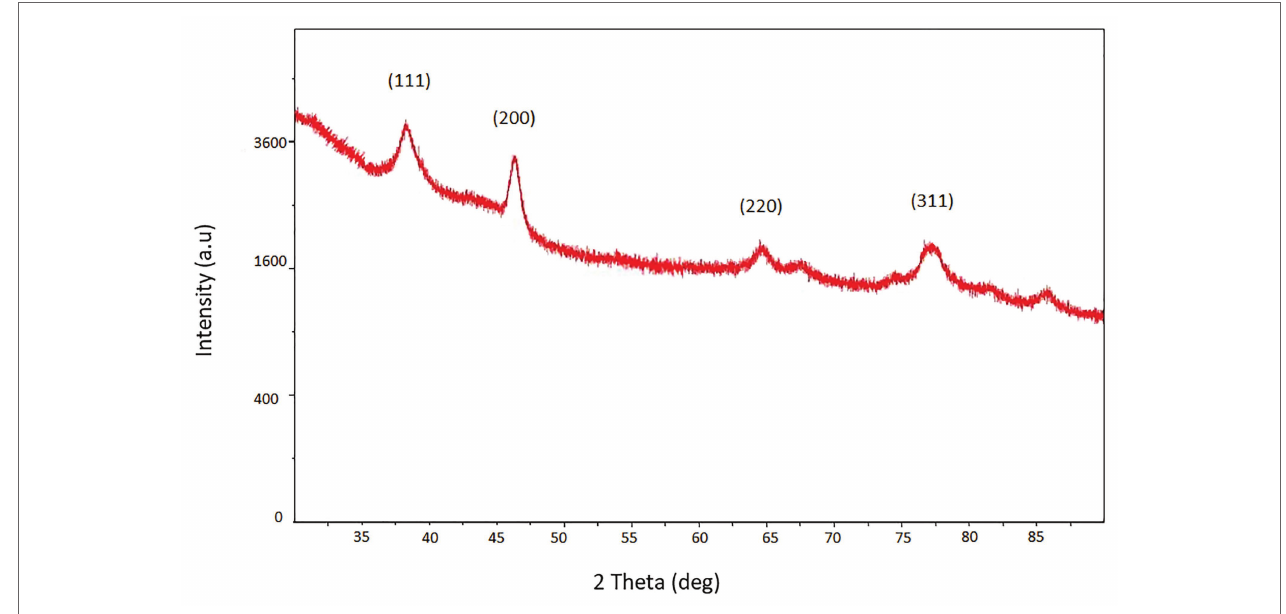
FIGURE 3 | XRD pattern of biosynthesized AgNPs.